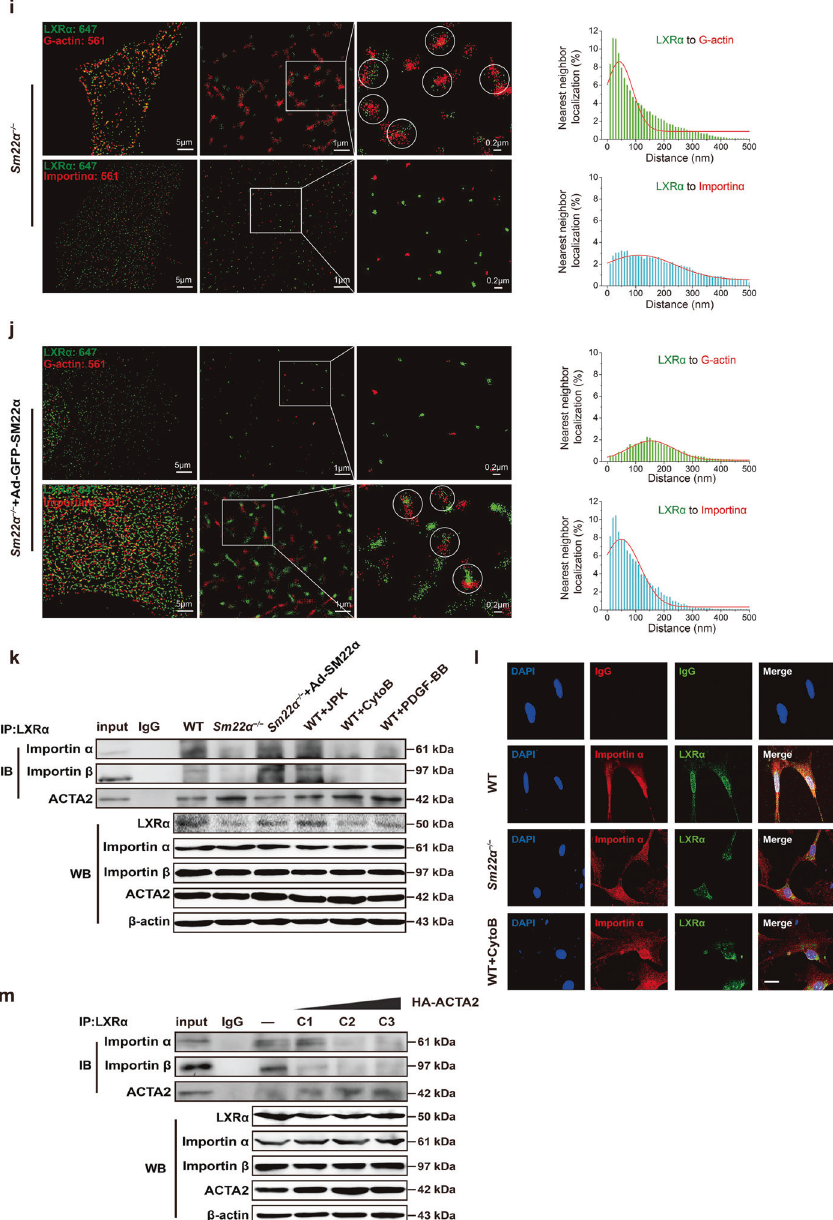
Fig. 5 G-actin interacts with and retains LXR α in the cytoplasm, blocking LXR α binding to Importin α . a Double immuno fl uorescence staining for G-actin (DnaseI, red) and LXR α (green) in WT VSMCs accompanied with treatment of JPK or CytoB and also in Sm22 α − / − VSMCs. Scale bar, 10 μ m. b , c Co-immunoprecipitation of ACTA2 and LXR α ( b ) and LXR β ( c ), respectively, in F- and G-actin fractions of WT and Sm22 α − / − VSMCs ( n = 3). d Double immuno fl uorescence staining of G-actin (Dnase1, red) and LXR α (green) or IgG in atherosclerotic lesion in aortic wall of Sm22 α − / − mice. Scale bar, 20 μ m. e Representative immuno fl uorescence staining for endogenous LXR α (green) and LXR α -GFP (green) in WT VSMCs transfected with HA-ACTA2 (red, stained by anti-HA antibody) or not. Scale bar, 15 μ m. f Representative immuno fl uorescence staining for LXR α -GFP (green) and HA-ACTA2 (red, stained by anti-HA antibody) in HEK-293A cells. Scale bar, 10 μ m. g – j Two-color STORM images and quanti fi cation of the co-localization degree between LXR α and G-actin as well as Importin α in WT VSMCs with ( h ) or without ( g ) CytoB treatment and Sm22 α − / − VSMCs with ( j ) or without ( i ) Ad-GFP-SM22 α infection ( n > 10). k Co-immunoprecipitation of LXR α and Improtin α , Improtin β or ACTA2 in WT and Sm22 α − / − VSMCs with or without JPK, CytoB, PDGF-BB, and Ad-GFP-SM22 α treatment ( n = 3). l Double immuno fl uorescence staining for Importin α (red) and LXR α (green) in WT and Sm22 α − / − VSMCs as well as CytoB-treated WT VSMCs. Scale bar, 15 μ m. m Co-immunoprecipitation of LXR α and Importin α , Improtin β or ACTA2 in WT VSMCs transfected with HA-ACTA2 of different concentration ( n = 3). Data and images represent at least three independent